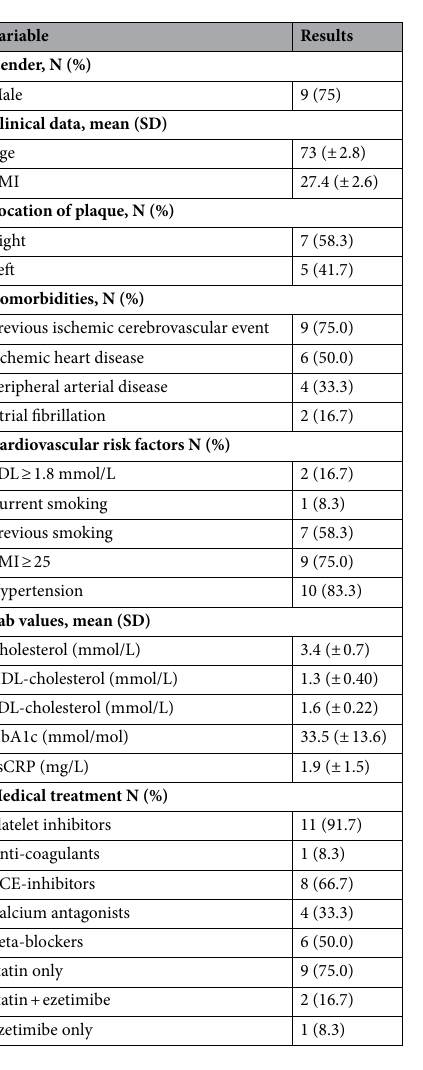
Table 1. Baseline characteristics. ACE angiotensin-converting-enzyme, BMI body mass index, CRP C-reactive protein, GFR glomerular filtration rate, HDL high-density lipoprotein, hsCRP high-sensitivity C-reactive protein, LDL low-density lipoprotein, N number of patients, TC total